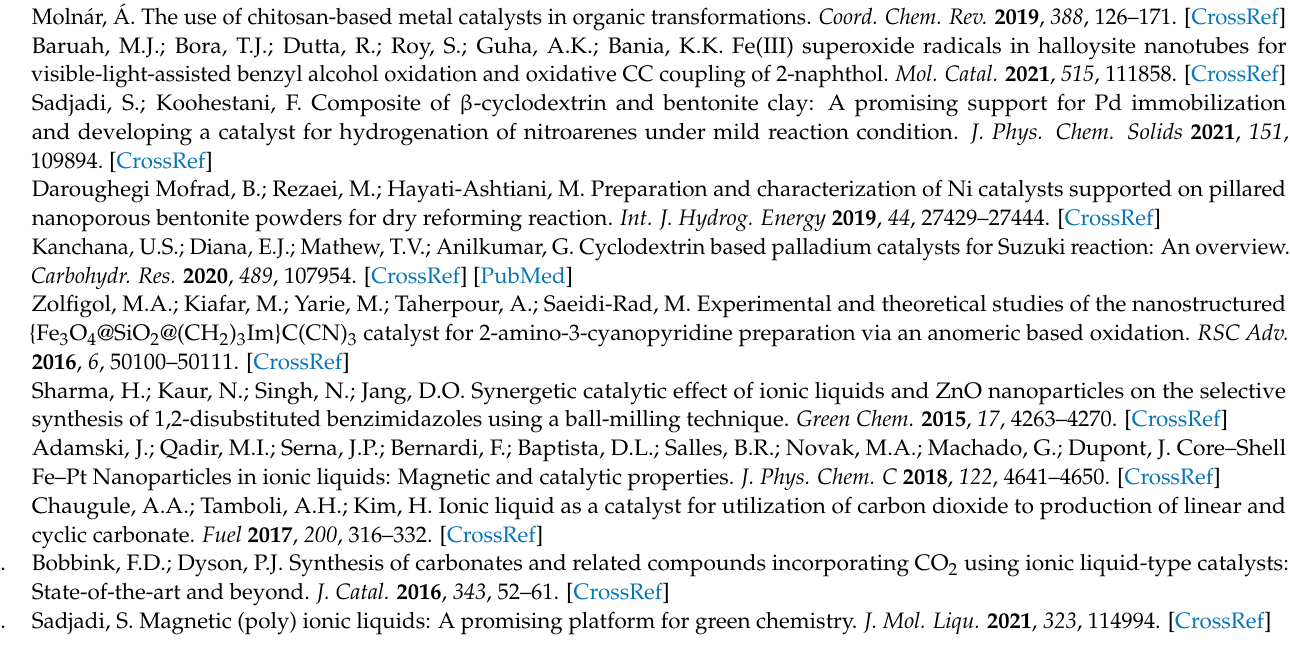
3-carbonitrile, Figure S8. Mass spectrum of 2-amino-7,7-dimethyl-4-(3-nitrophenyl)-5-oxo-5,6,7,8- tetrahydro-4 H -chromene-3-carbonitrile, Figure S9. FTIR spectrum of 2-amino-7,7-dimethyl-4-(3- nitrophenyl)-5-oxo-5,6,7,8-tetrahydro-4 H -chromene-3-carbonitrile, Figure S10. 13 CNMR spectrum of 2-amino-4-(4-hydroxyphenyl)-7,7-dimethyl-5-oxo-5,6,7,8-tetrahydro-4 H -chromene-3-carbonitrile, Figure S11. 1 HNMR spectrum of 2-amino-4-(4-chlorophenyl)-7,7-dimethyl-5-oxo-5,6,7,8-tetrahydro- 4 H -chromene-3-carbonitrile, Figure S12. FTIR spectrum of 2-amino-4-(4-chlorophenyl)-7,7-dimethyl- 5-oxo-5,6,7,8-tetrahydro-4 H -chromene-3-carbonitrile, Figure S13. Mass spectrum of 2-amino-4-(4- chlorophenyl)-7,7-dimethyl-5-oxo-5,6,7,8-tetrahydro-4 H -chromene-3-carbonitrile, Figure S14. 13 CNMR spectrum of 2-amino-4-(4-chlorophenyl)-7,7-dimethyl-5-oxo-5,6,7,8-tetrahydro-4 H -chromene-3-carbo- nitrile, Figure S15. FTIR spectrum of 2-amino-7,7-dimethyl-5-oxo-4-phenyl-5,6,7,8-tetrahydro-4 H - chromene-3-carbonitrile, Figure S16. 13 CNMR spectrum of 2-amino-7,7-dimethyl-5-oxo-4-phenyl- 5,6,7,8-tetrahydro-4 H -chromene-3-carbonitrile, Figure S17. 1 HNMR spectrum of 2-amino-7,7-dimethyl- 5-oxo-4-phenyl-5,6,7,8-tetrahydro-4 H -chromene-3-carbonitrile, Figure S18. FTIR spectrum of 2- amino-7,7-dimethyl-4-(4-nitrophenyl)-5-oxo-5,6,7,8-tetrahydro-4 H -chromene-3-carbonitrile, Figure S19. 1 HNMR spectrum of 2-amino-7,7-dimethyl-4-(4-nitrophenyl)-5-oxo-5,6,7,8-tetrahydro-4 H -chro- mene-3-carbonitrile, Figure S20. Mass spectrum of 2-amino-7,7-dimethyl-4-(4-nitrophenyl)-5-oxo- 5,6,7,8-tetrahydro-4 H -chromene-3-carbonitrile, Figure S21. 1 HNMR spectrum of 2-amino-4-(2- chlorophenyl)-7,7-dimethyl-5-oxo-5,6,7,8-tetrahydro-4 H -chromene-3-carbonitrile, Figure S22. 1 HNMR spectrum of 2-amino-4-(2,6-dichlorophenyl)-7,7-dimethyl-5-oxo-5,6,7,8-tetrahydro-4 H -chromene-